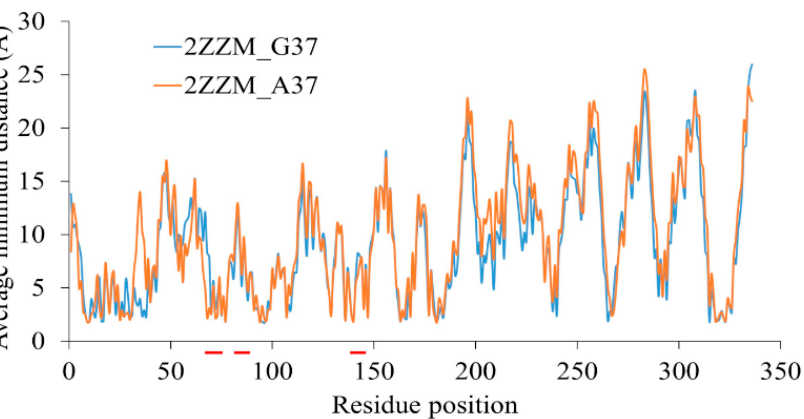
Figure 6. Average minimum distance of wild-type aTrm5 complex (2ZZM_G37) and tRNA G37A mutant aTrm5 complex (2ZZM_A37) for the last 80 ns of simulations. The DOT regions are marked with red colour in the X-axis.